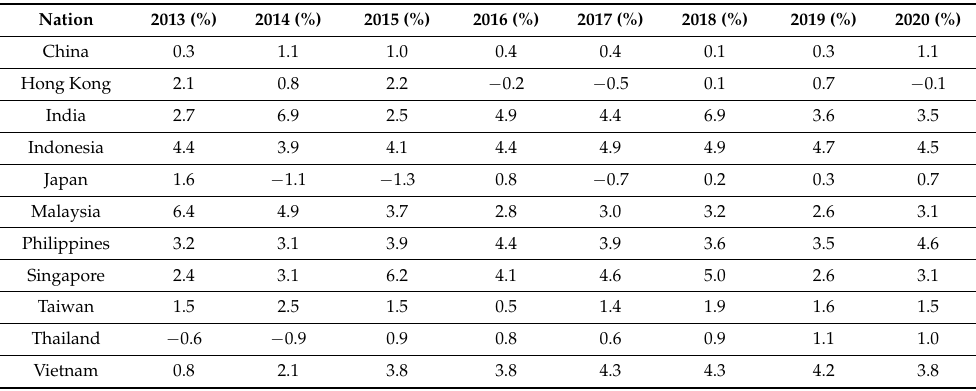
Table 1. Data and forecasting growth consumption